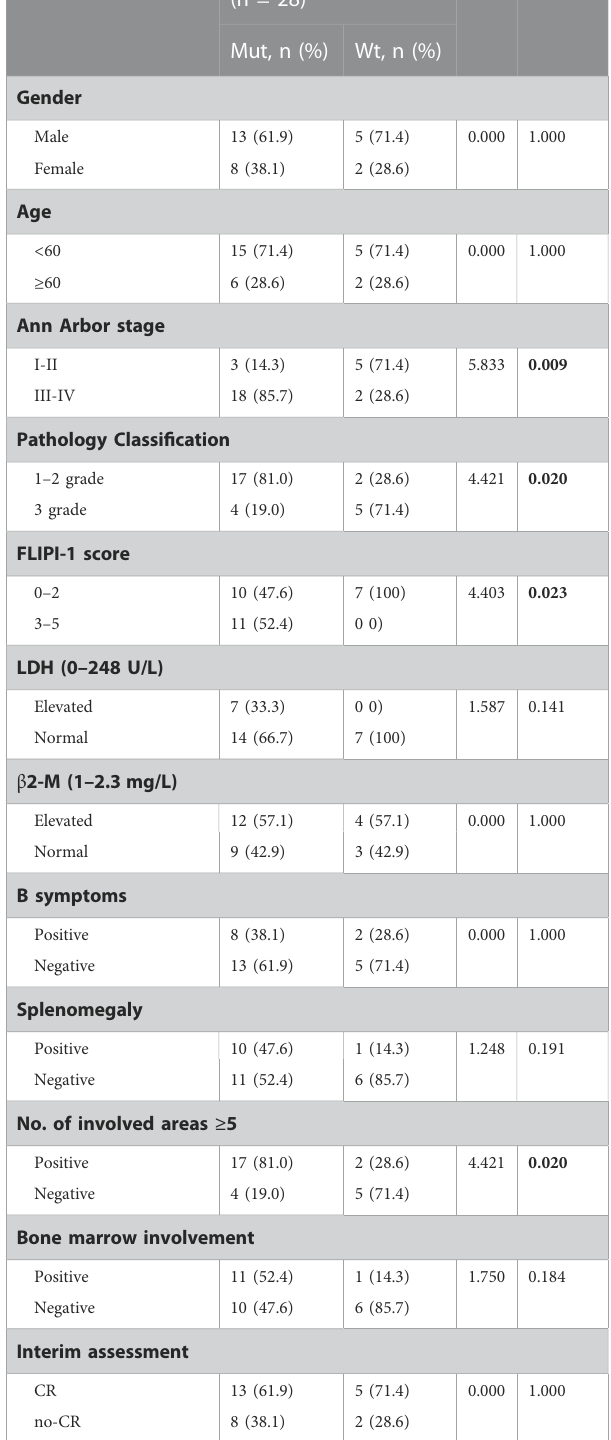
TABLE1TheclinicopathologicfeaturesofFLpatientswithmutationorwithout mutation. Clinical